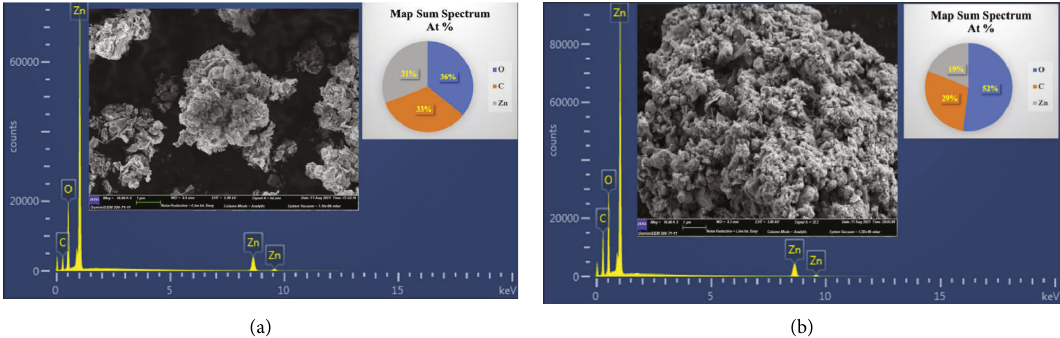
Figure 2: SEM-EDX images of (a) zinc oxide nanoparticles (ZnONPs) and (b) plant-fabricated zinc oxide nanoparticles (PF-ZnONPs).